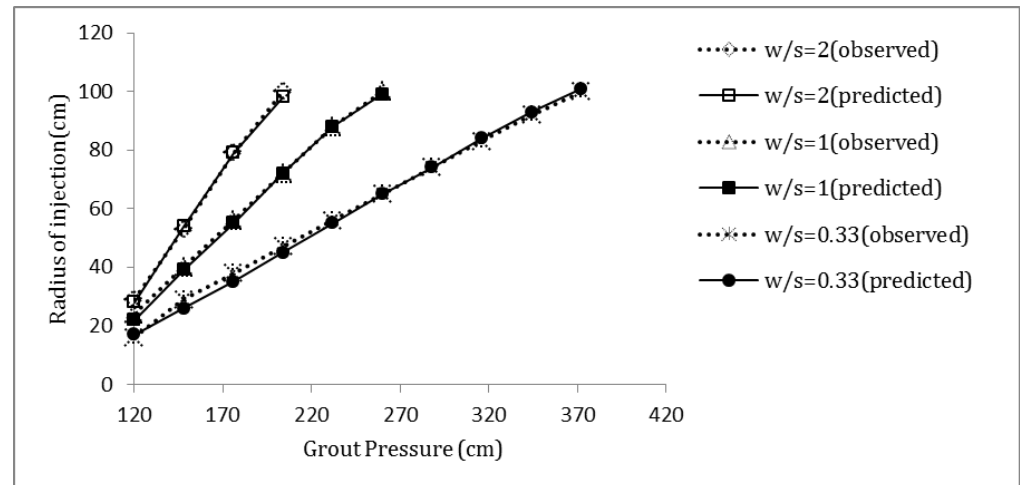
Fig. 7. Effect of grout viscosity (W/S ratio) on the radius of slurry injection based on experimental tests and ANN predictions (medium soil and